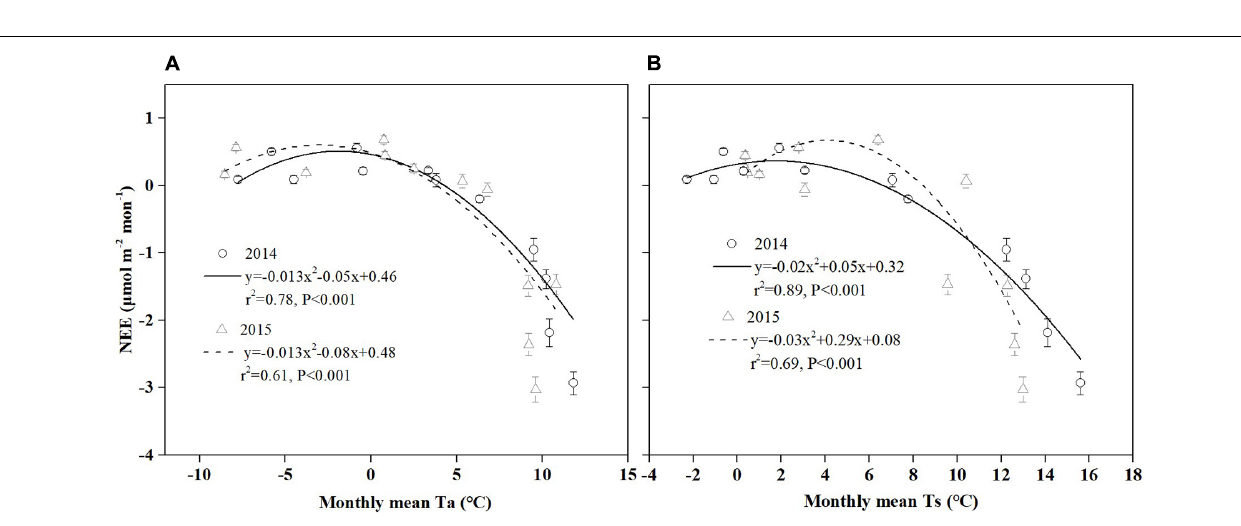
between NEE and diverse variables (PAR, VPD, Ta, and Ts) flux and these variables was different, especially on